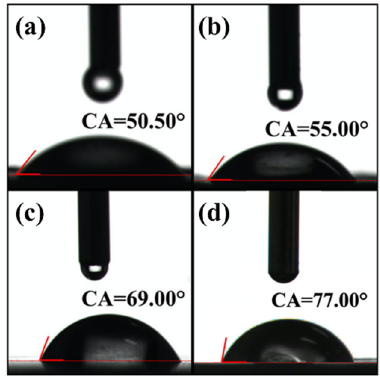
Figure 5. Photos of contact angle of graphite pellets: ( a ) untreated graphite ore with deionized water; ( b ) graphite ore with 0.2 mol/L MgCl 2 solution; ( c ) kerosene-treated graphite with deionized water; ( d ) kerosene-treated graphite with 0.2 mol/L MgCl 2 solution.